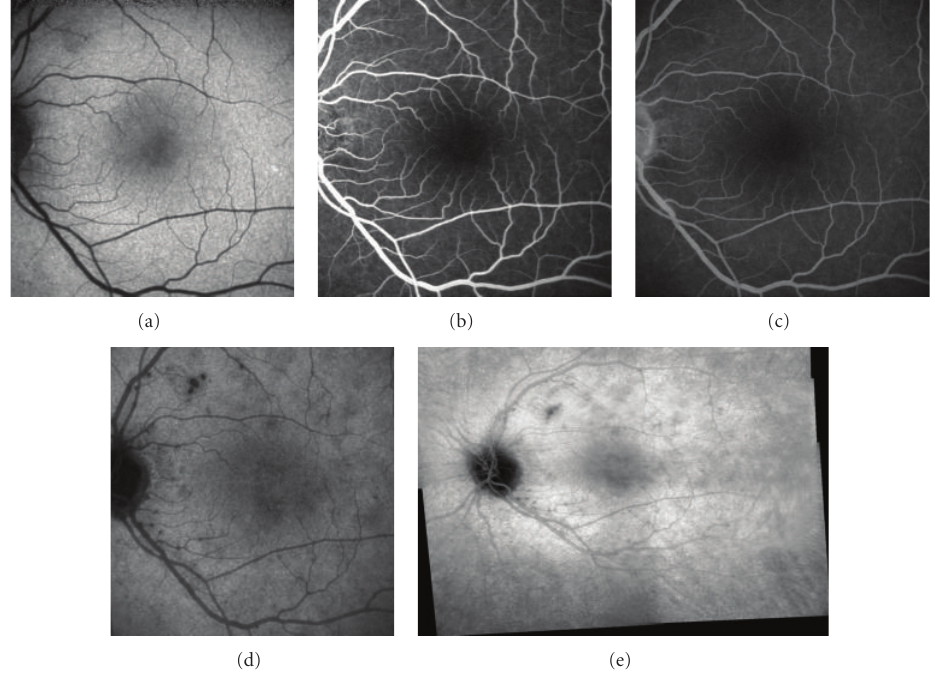
Figure 2: Thirty-day follow-up visit. (a) Normal fundus autofluorescence exam. (b) Early frame of normal fluorescein angiogram (FA). (c) Late frame FA with no hyperfluorescent lesion. (d) Late frame indocyanine green angiogram reveals hypofluorescent lesions mainly in peripapillary area. (e) Panoramic reconstruction of ICGA showing small hypofluorescent